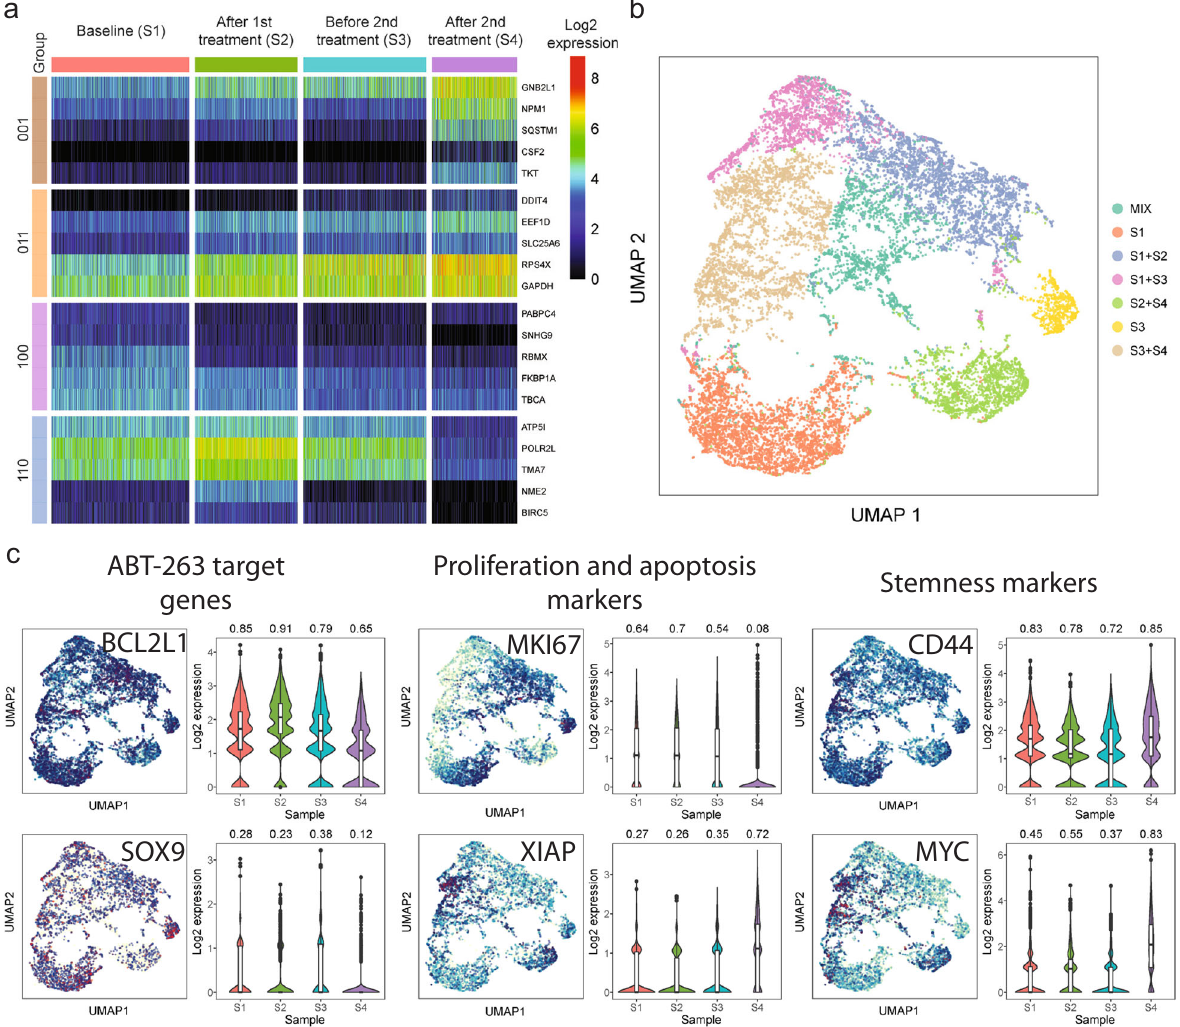
Fig. 6 Effects of navitoclax treatment at the single-cell level. a Expression heatmap of top fi ve markers of 4 important cell groups de fi ned in DNA-barcoding experiment. b UMAP plot presenting cell clustering after alignment of the samples. The name of each cluster represents the dominance of cells from particular samples. c Expression of selected important genes presented on UMAP plot (left side) and summarized on boxplot (right side). Above each boxplot, there is a proportion of expressed cells per